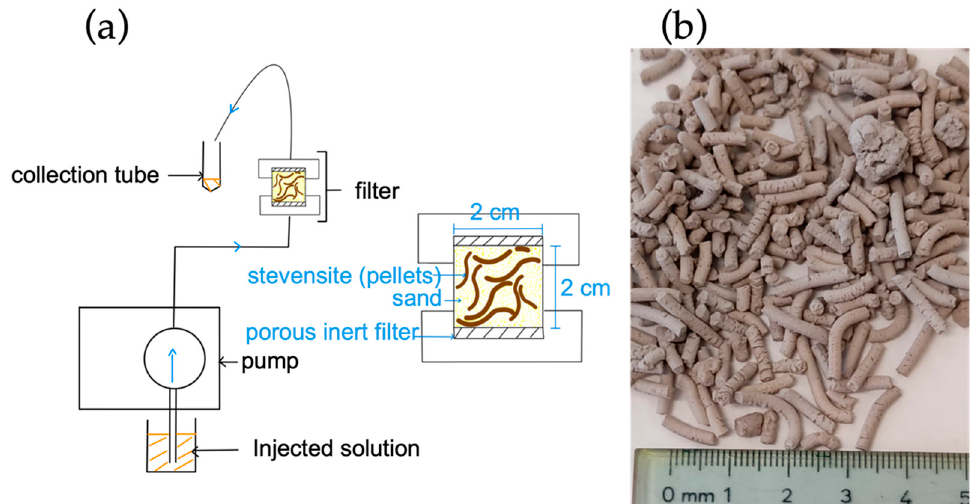
Figure 2. ( a ) Scheme of the experimental set-up of reactive transport experiments; ( b ) aspect of the stevensite pellets. stevensite